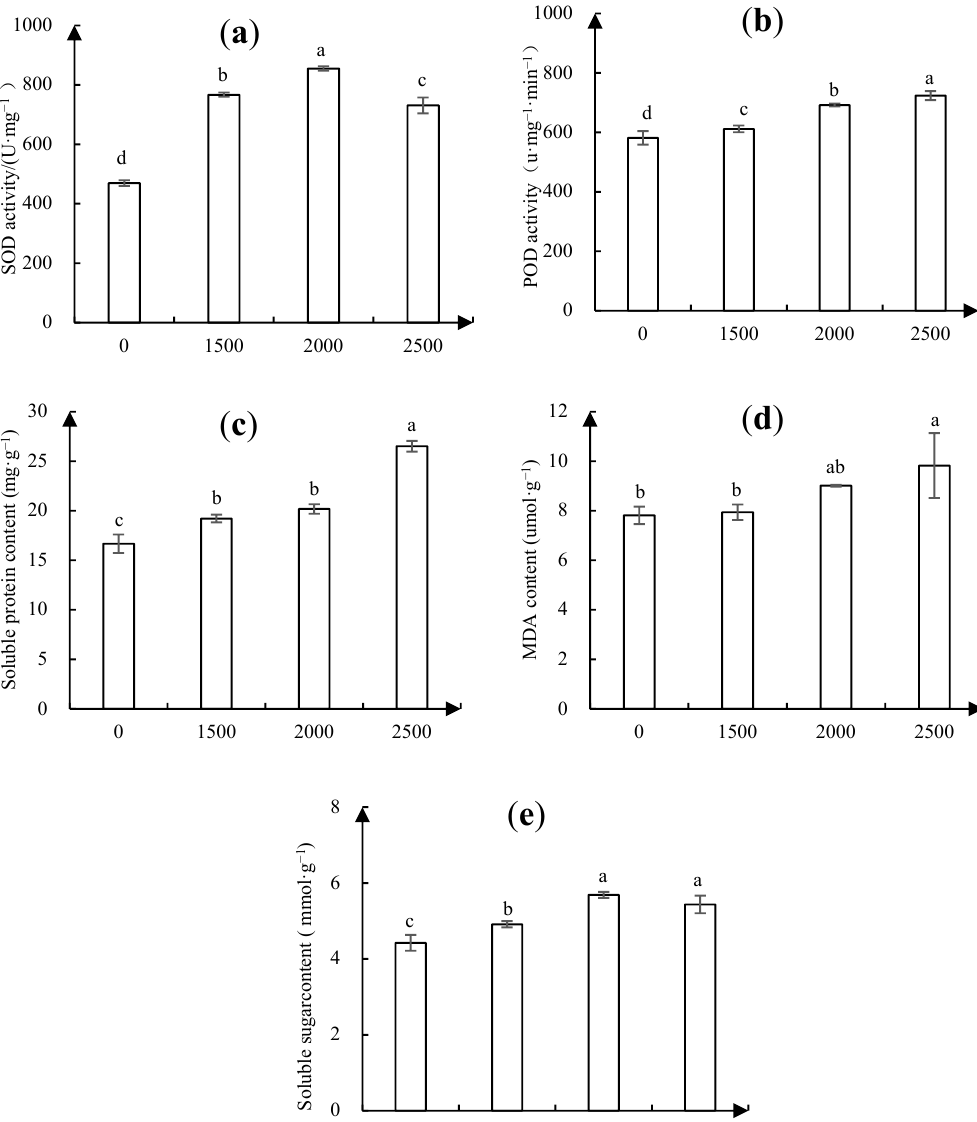
Figure 5. The effects of different concentrations of uniconazole on SOD activity ( a ), POD activity ( b ), soluble protein content ( c ), MDA content ( d ) and soluble sugar content ( e ) in M. wufengensis .